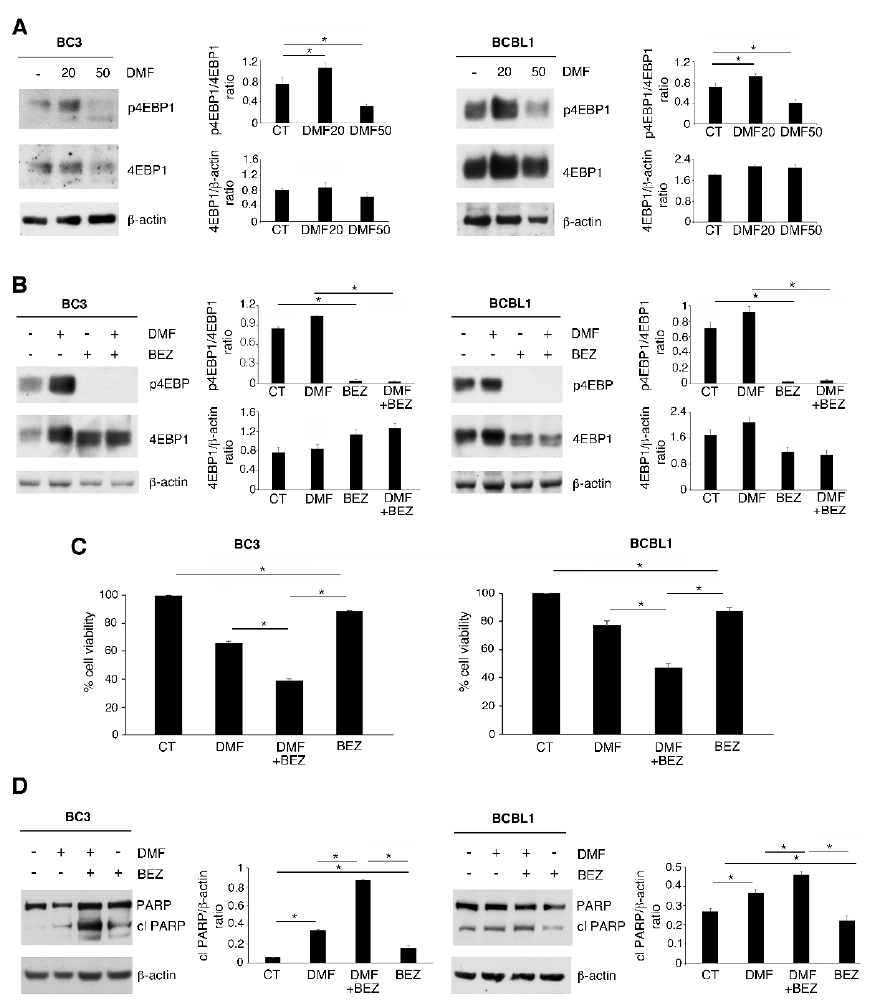
Figure 2. mTOR pathway activation reduces DMF cytotoxicity in PEL cell lines. Western blot anal- ysis was used to detect 4EBP1 phosphorylation (p-4EBP1) in BC3 and BCBL1 cells, ( A ) treated or